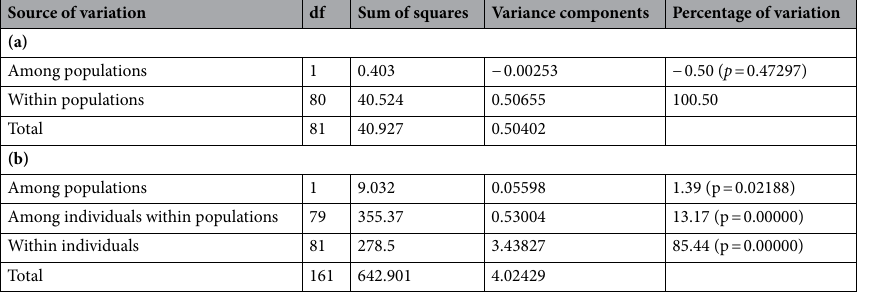
Source of variation df Sum of squares Variance components Percentage of